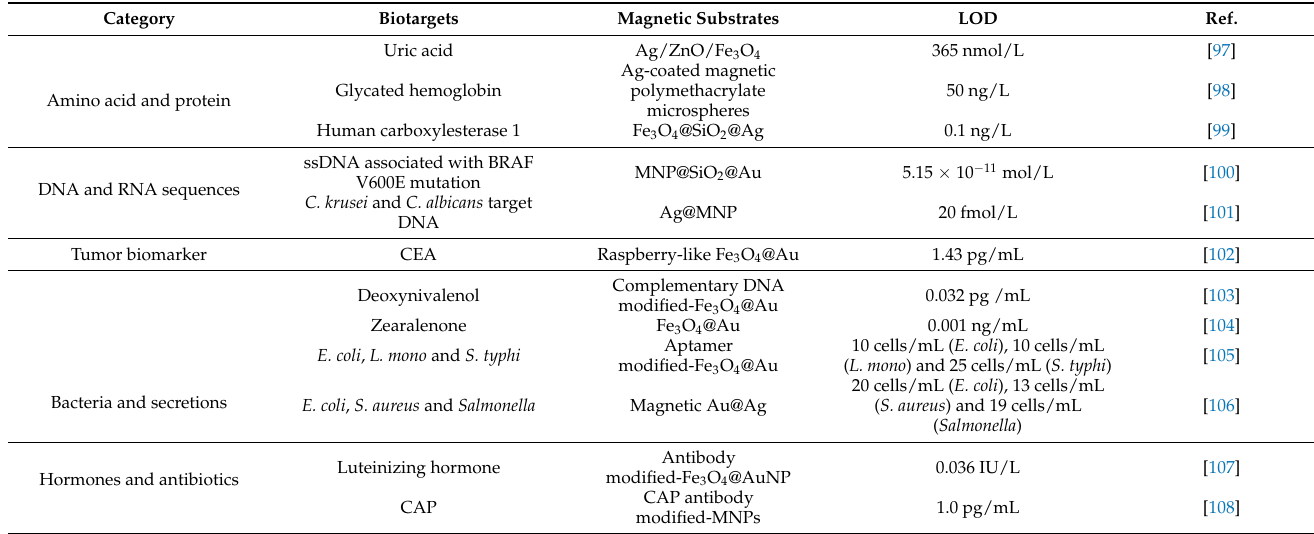
Table 1. Typical application of magnetic substrates for SERS